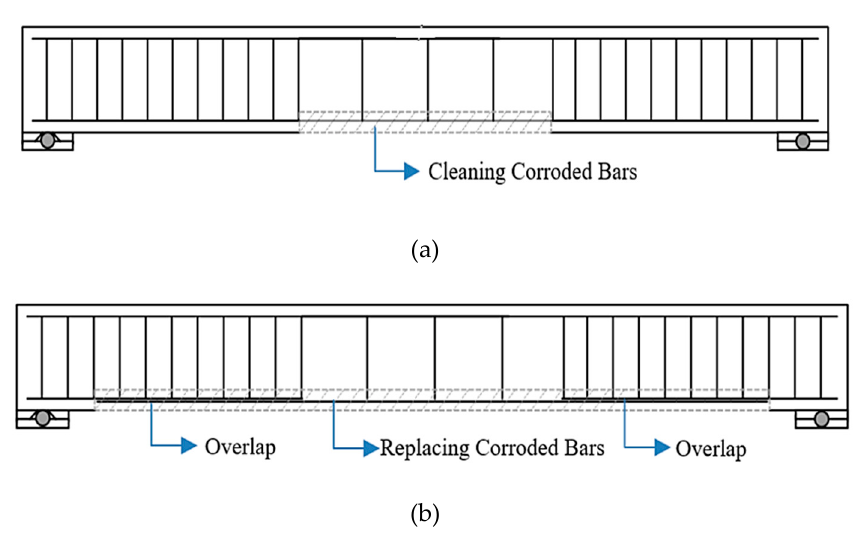
Figure 3. Detail of the patch repair technique. ( a ) patch repair by cleaning corroded steel bars; ( b ) Patch repair by replacing corroded steel bars.